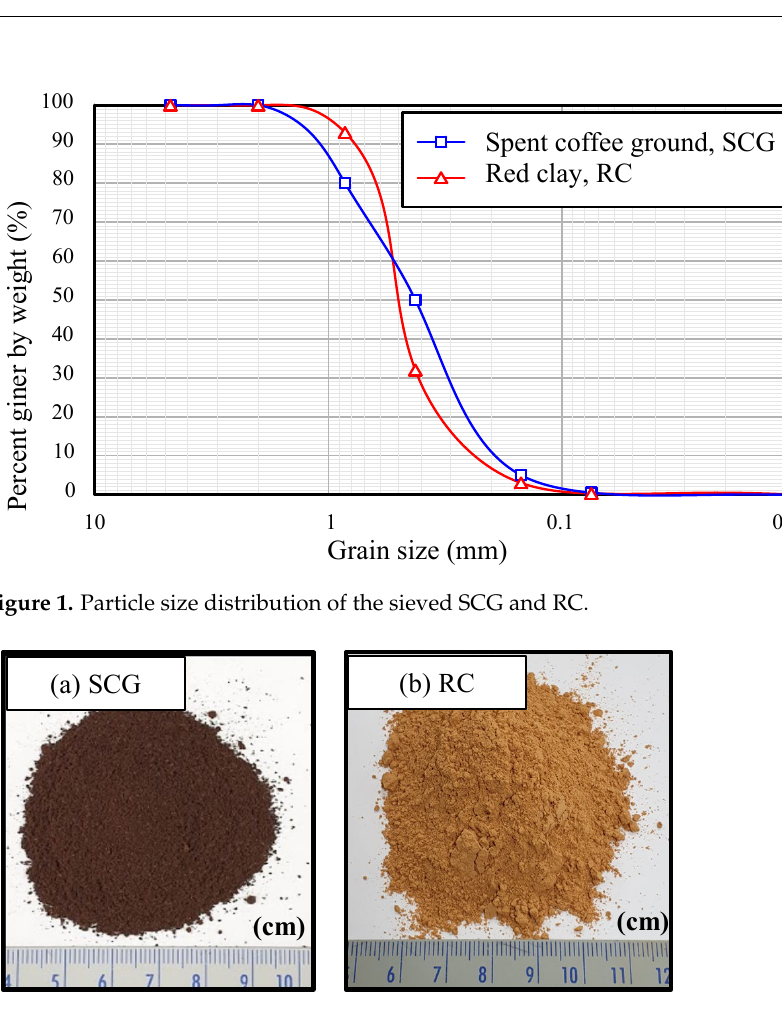
Figure 2. Optical photos of spent coffee grounds ( a ) and red clay ( b ).